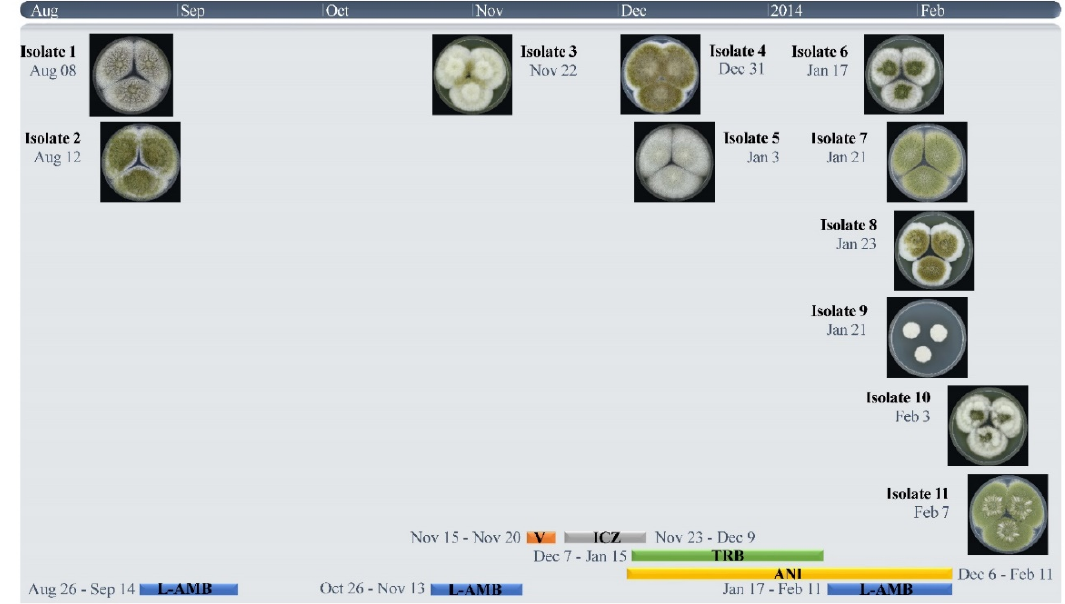
Figure 2. Timeline of the antifungal treatment and A. flavus culture morphology. VCZ, voriconazole; ICZ, itraconazole; L-AMB, liposomal amphotericin B; TRB, terbinafine; ANI, anidulafungin. The dates that clinical samples were obtained from the patient are indicated in the Figure, and the numbering of the isolates is based on the date the cultures became positive. Isolates 7 and 9 were cultured from the same clinical material but showed different morphologies. Isolate 8 was cultured from a clinical sample obtained 2 days after Isolates 7 and 9. This culture was earlier positive than the cultures of Isolate 9.2.2. Strains, phenotypic analysis, antifungal susceptibility and